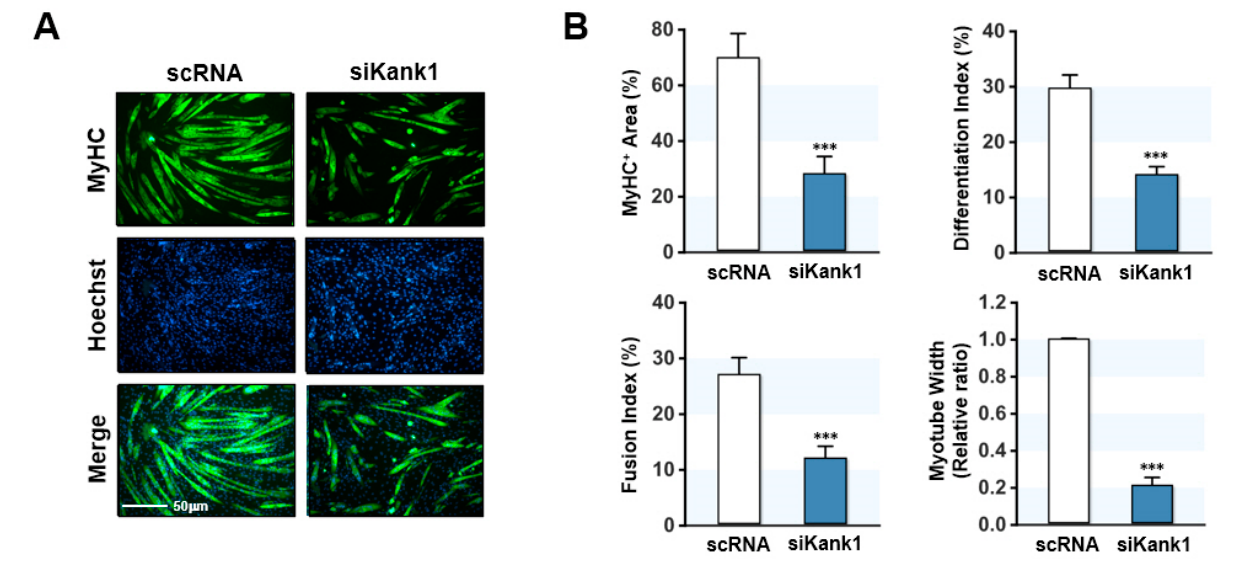
Figure 5. Kank1 knockdown impeded myogenic differentiation and myotube formation. C2C12 cells were differentiated for 5 days after transfection with control (scRNA) or Kank1 siRNA (siKank1). ( A ) Representative immunocytochemistry stained with MyHC antibody (green) and Hoechst 33,342 (blue). Scale bar: 50 µ m. ( B ) MyHC-positive areas, differentiation indices, fusion indices, and myotube widths were determined as described in the Materials and Methods section. All results are presented as means ± SEMs ( n > 3), and levels of significance are presented as ***, p < 0.001 vs. scRNA controls.